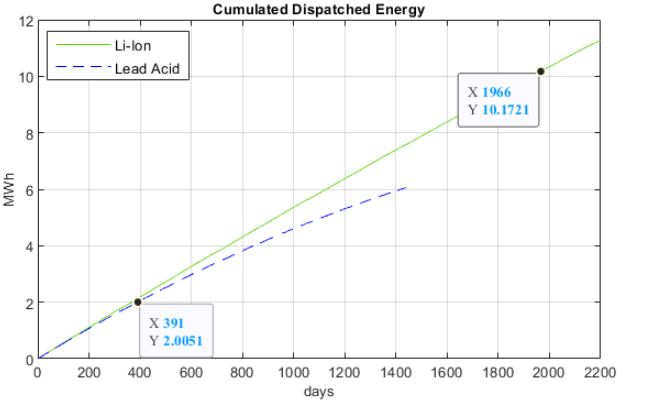
Figure 13. Battery capacity losses and daily dispatched energy (lithium battery bank).